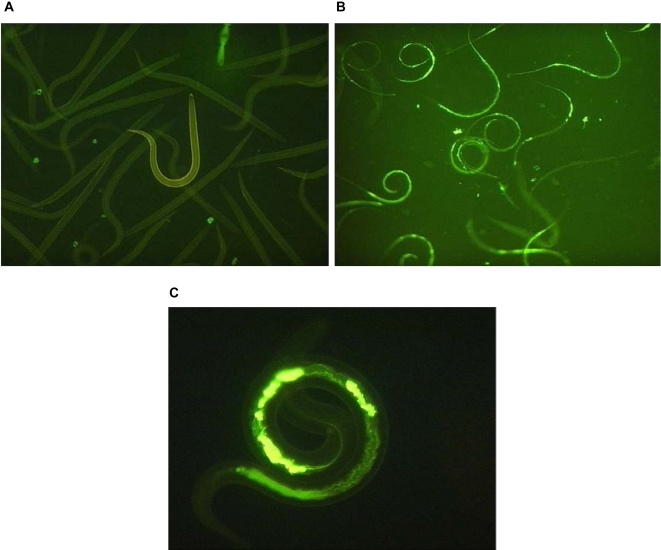
Example of A. caninum third-stage larvae (L3) ingesting fluorescein-conjugated bovine serum albumin (FITC-BSA) following serum-stimulation activation in vitro.Ensheathed (non-activated) L3 do not ingest FITC-BSA (A) whereas serum-stimulation activated L3 ingest the dye and exhibit strong fluorescence from the gut (B-100×magnification; C-400×magnification).